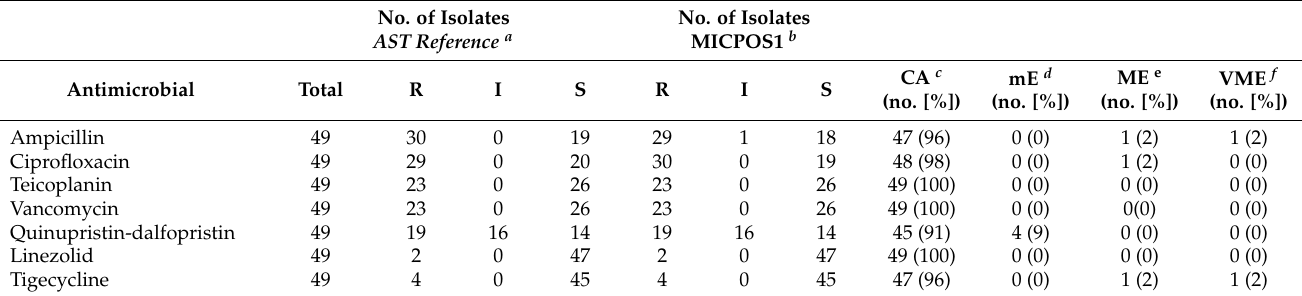
Table 3. Results for Enterococci tested with the MICPOS1 standard turbidity inoculum method and visual reading versus AST reference methods.